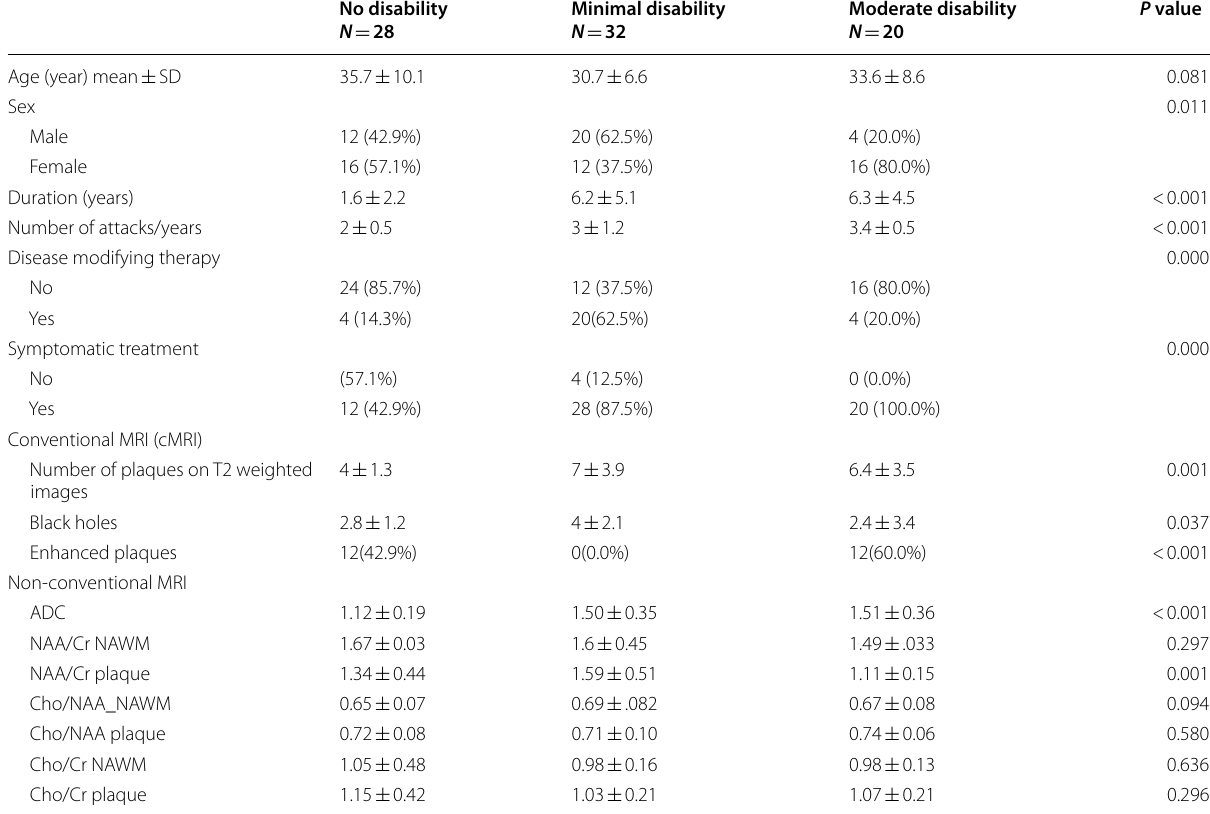
Cho/Cr choline/creatine; Cho/NAA choline/ N -acetyl-aspartate; NAA/Cr N -acetyl-aspartate/creatine; EDSS expanded disability status scale; NAWM normal appearing white matter